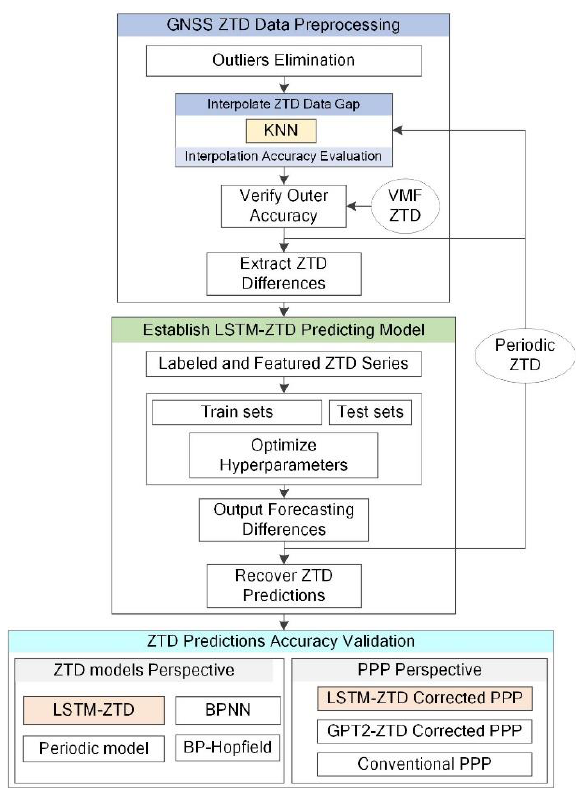
Figure 1. Main procedures flow chart to establish the LSTM-ZTD forecast